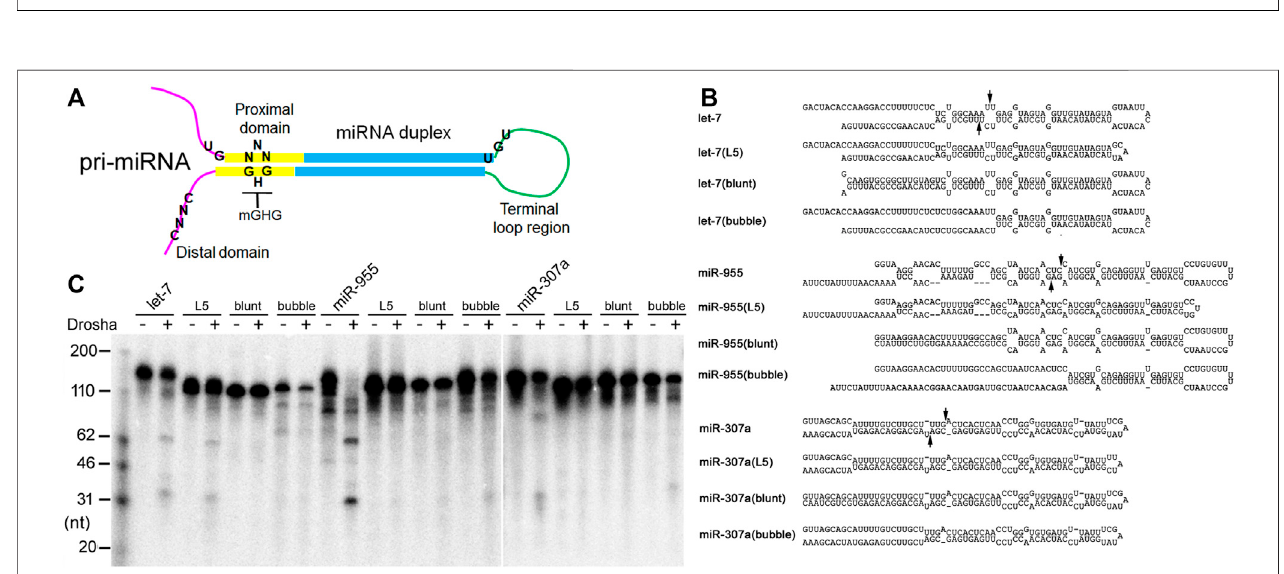
FIGURE 5 | Pri-miRNA preferences by Drosha. (A) Schematics of an animal pri-miRNA. The important secondary structural features are shown, along with positions of the UG, UGU, mGHG, and CNNC motifs. (B) Predicted secondary structures of dme-pri-miRNAs and their mutants. Arrows point to Drosha cleavage sites predicted by miRBase. (C) Fruit fl y Drosha processing of the dme-pri-miRNAs and their mutants. Positions of DNA markers are shown in the left.